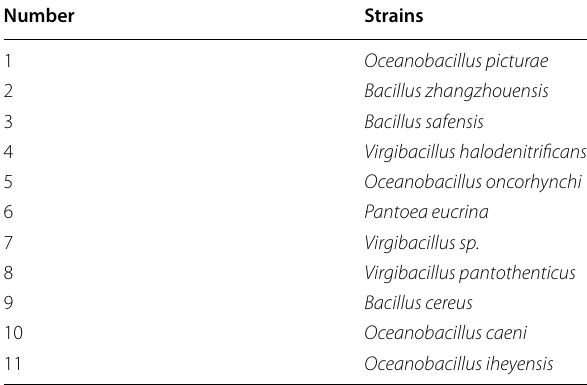
Table 1 Sequence number of BA degrading bacteria